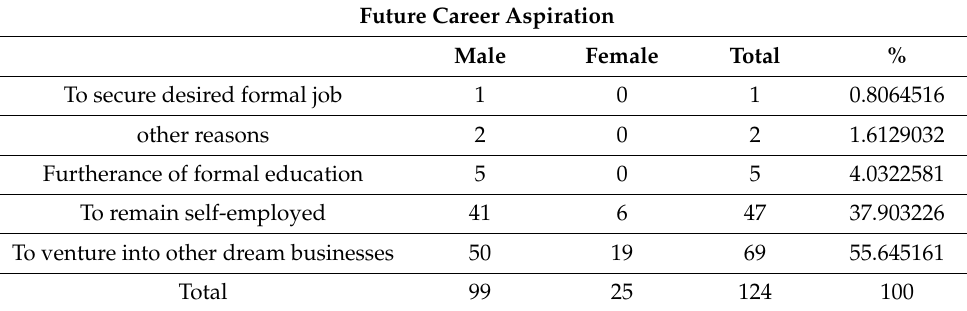
Figure 6. Future career aspiration of waste pickers in Lagos State, Nigeria. Source: Computed by authors. Table 6. Future career aspiration of waste pickers in Lagos State,